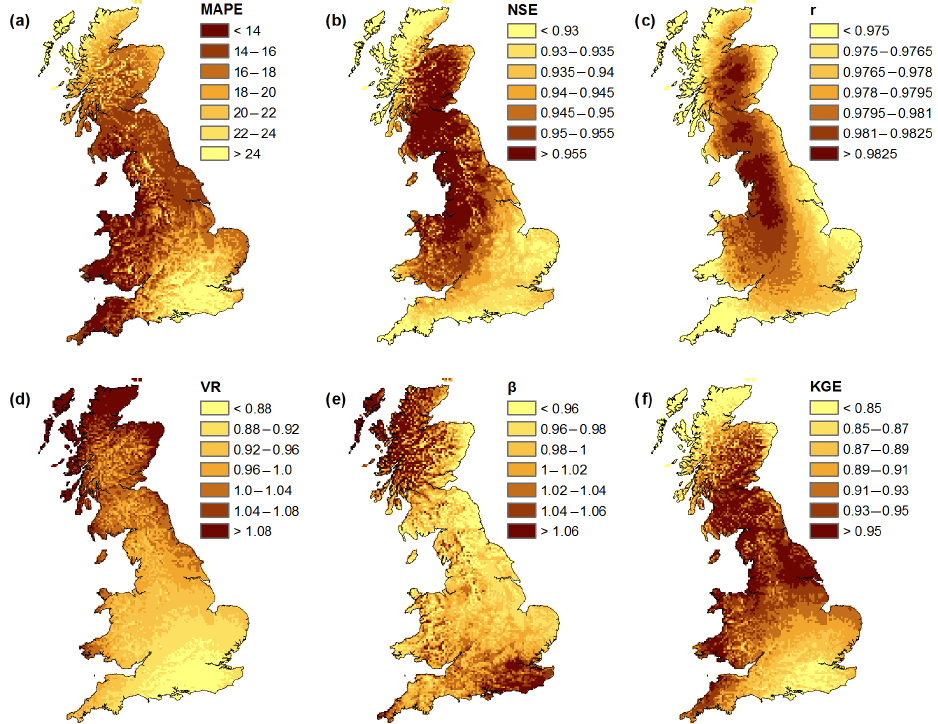
Figure 6. Grids of evaluation metrics for the new monthly gridded PET dataset. The darker the colour, the better the performance for all metrics represented, except for the variability ratio (VR) (d) and bias ratio ( β ) (e) where the middle-range colour is optimal.